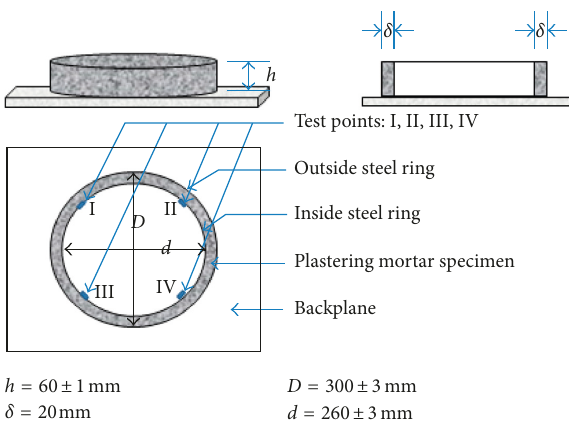
Figure 2: Schematic diagram of the ring restraint test